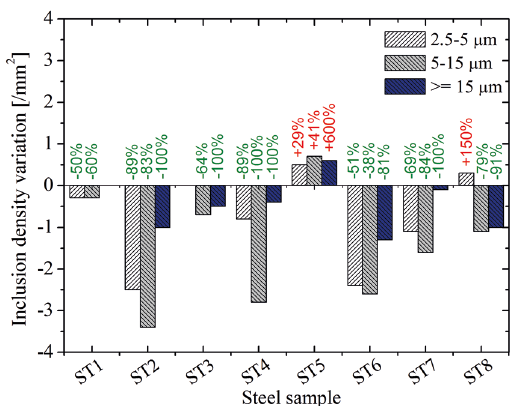
Figure 4. Inclusion density variation after vacuum degassing for each steel